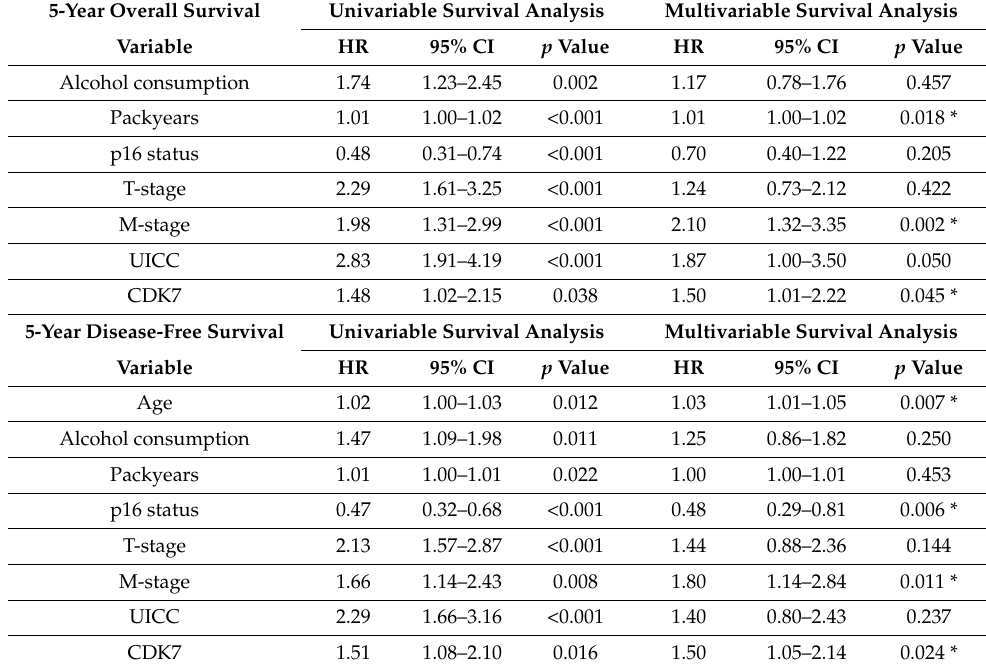
Table 2. Cox regression analysis of CDK7 expression. * p < 0.05.